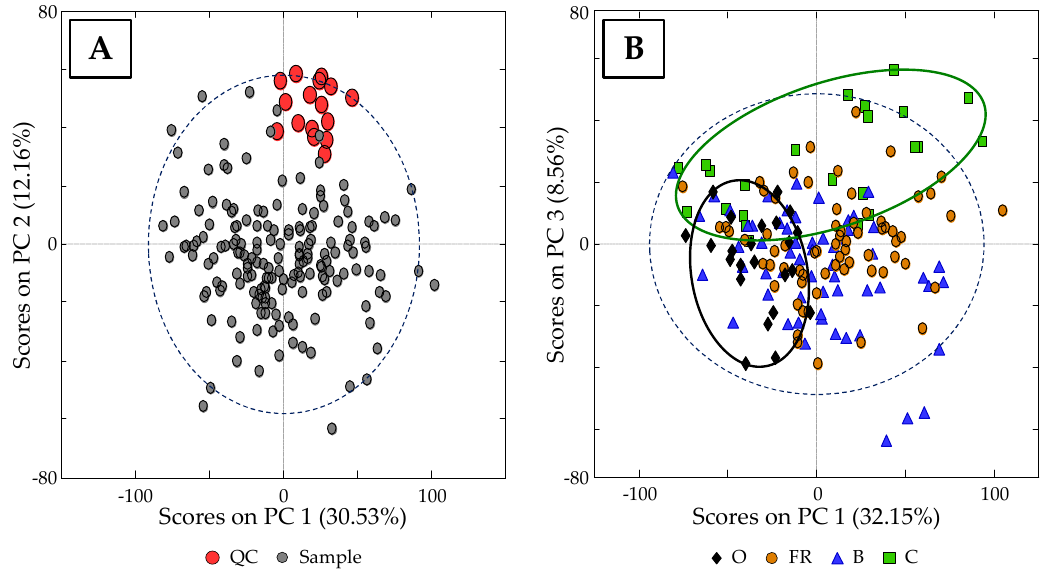
Figure 3. ( A ) Scores plot of PC1 vs. PC2 when using HPLC-UV fingerprints registered at 250 nm as chemical descriptors, showing a correct behavior of quality control (QC) samples. ( B ) Scores plot of PC1 vs. PC3, without including QC samples, showing a slight trend of organic hen (O) and caged hen (C) eggs.